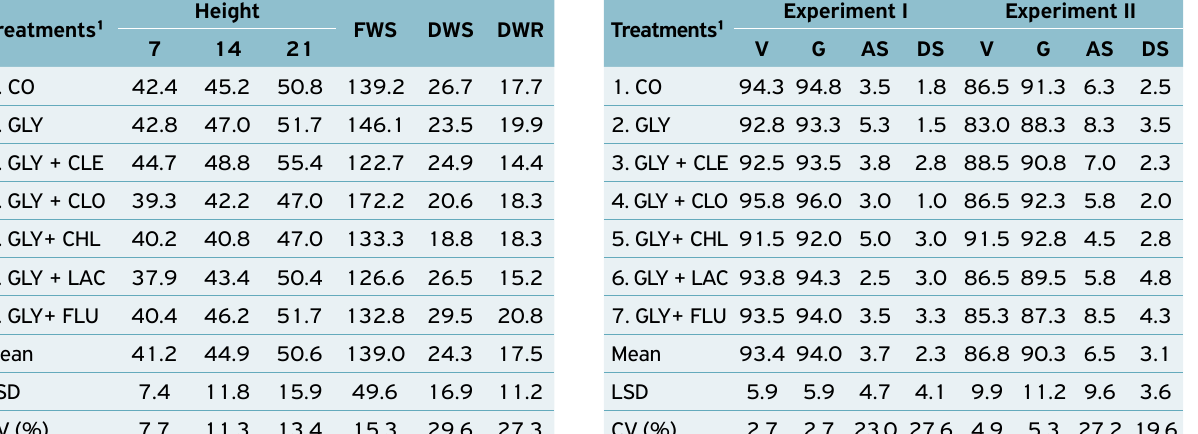
Table 7. Height at 7, 14 and 21 days after application (cm), fresh and dry weight of shoot and roots² (g) of RR2 soybean subjected to application of glyphosate, alone or in combination, at post‑emergence (V4). Piracicaba, state of São Paulo, greenhouse 2014 (experiment III).